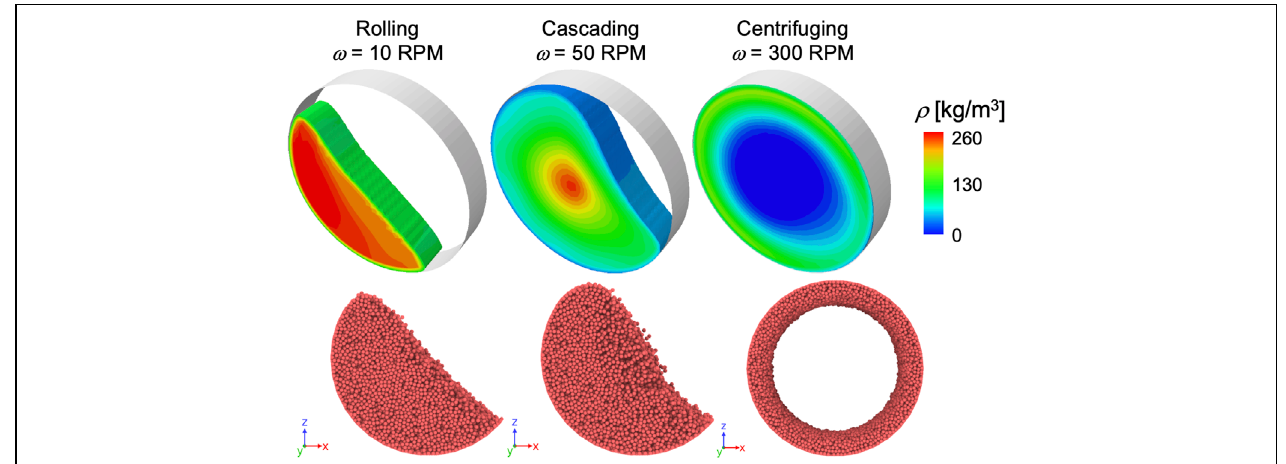
FIGURE 7 | Three particle flow patterns observed at different rotational speeds. The top row are snapshots obtained from FEM simulations, while the DEM snapshots are displayed at the bottom row.